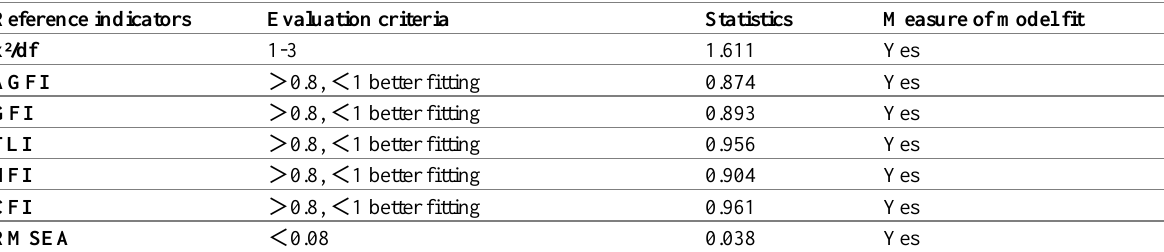
Figure 3: Overall CFA graph for all dimensions of “New Guochao” brands (such as content marketing) Table 3: Indicators of goodness of fit of the global